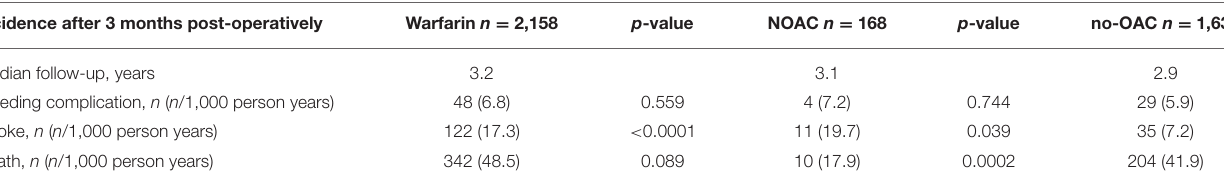
TABLE 3 | Risk of complications in OAC users vs. no-OAC patients.